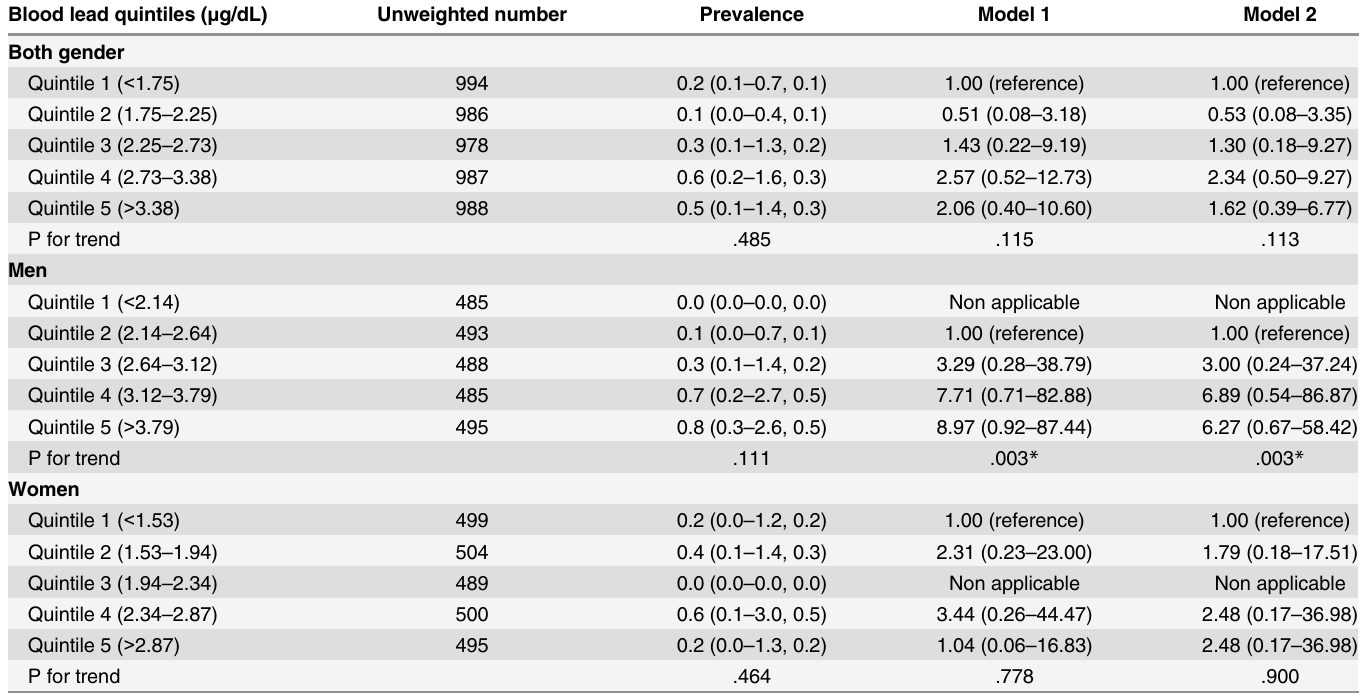
Table 5. Prevalence and adjusted odds ratio of late type of age-related macular degeneration (AMD), stratified according to quintile category of blood lead among representative Korean adults aged 40 years or older. Prevalence is expressed as weighted estimates [%] (95% confidence intervals, standard errors [%]).